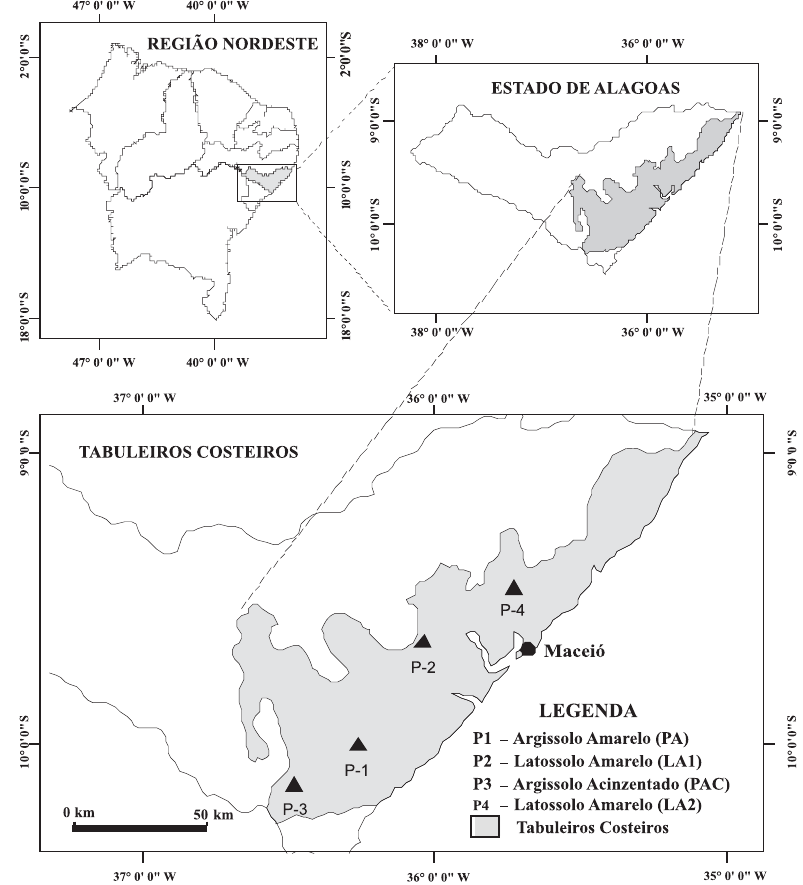
Figura 1. Localização das áreas de coleta dos